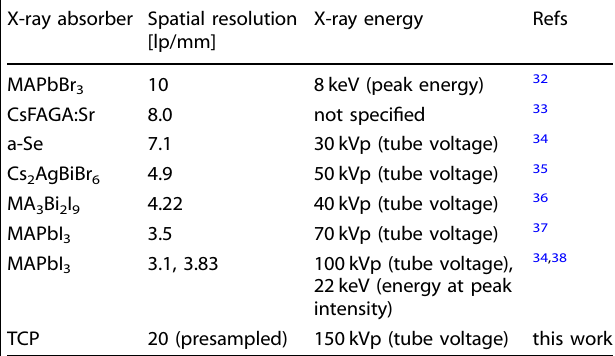
Table 1. Spatial resolution reached with other X-ray